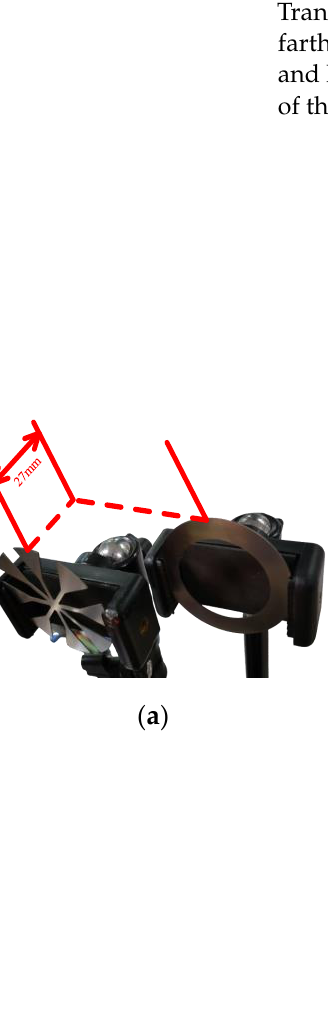
Figure 11. Different-Distance multiple targets: ( a ) scenario; ( b ) Back Projection; ( c ) Matched Filter; ( d ) Analytic Fourier Transform; ( e ) mmSight.